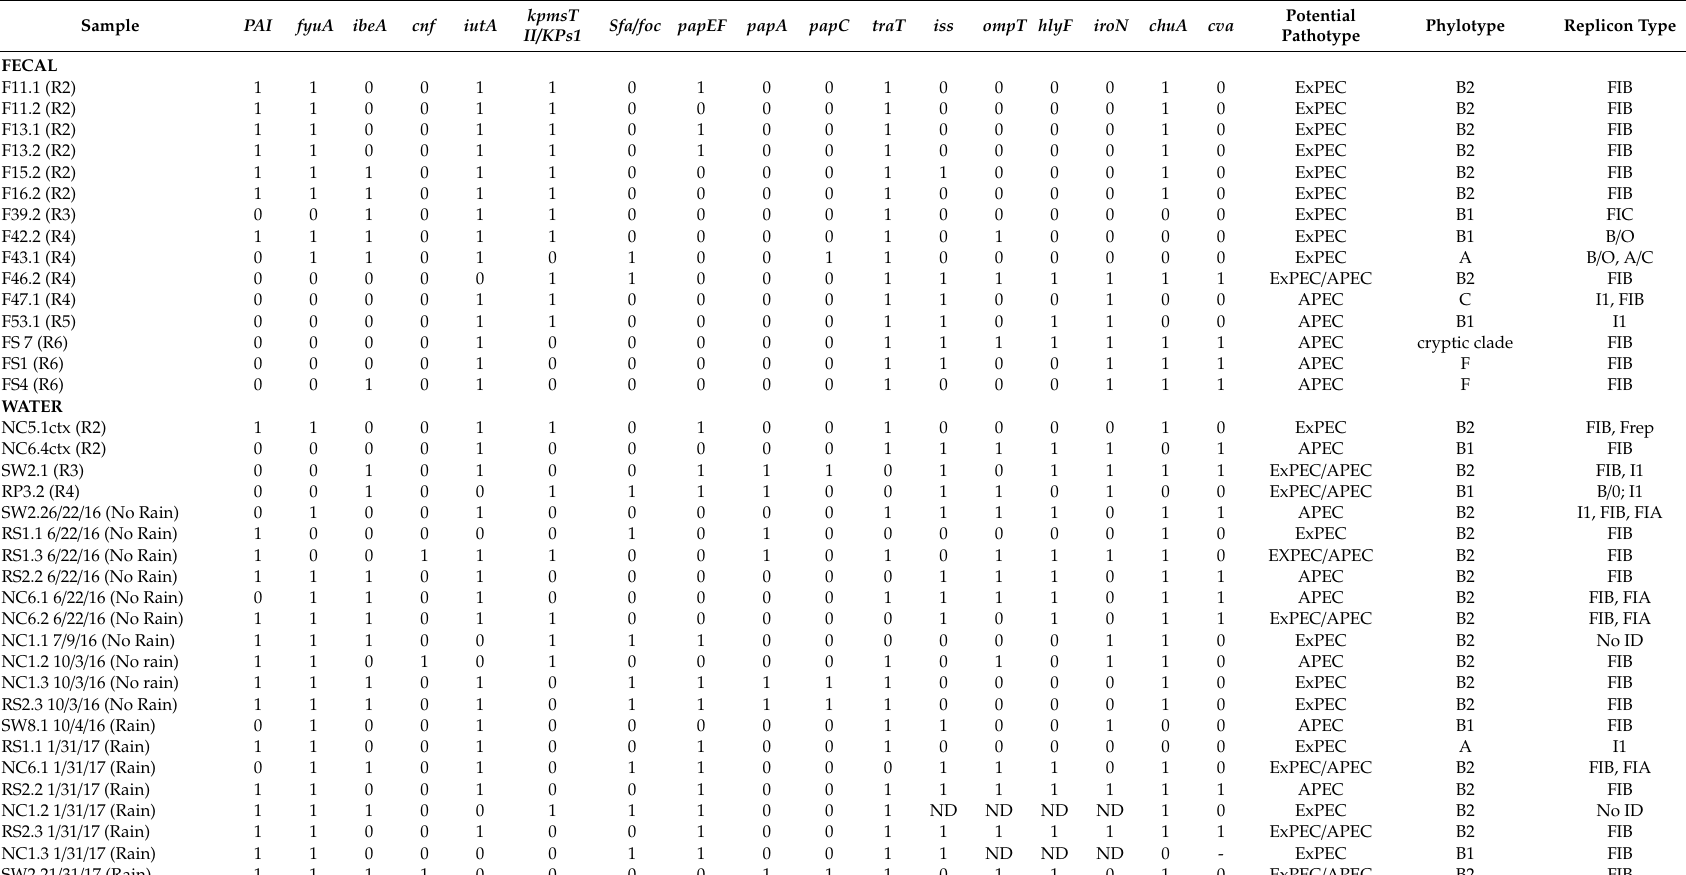
Table 1. Virulence Profile of Fecal and Water